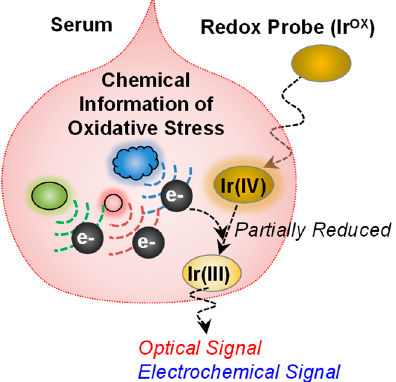
Figure 5. Redox-probing to access chemical information of oxidative stress. The redox mediator (K 2 IrCl 6 , Ir OX ) can probe chemical information relevant to oxidative stress in blood. The information can be transmitted into optical and electrochemical modalities. Adapted with permission from [55].